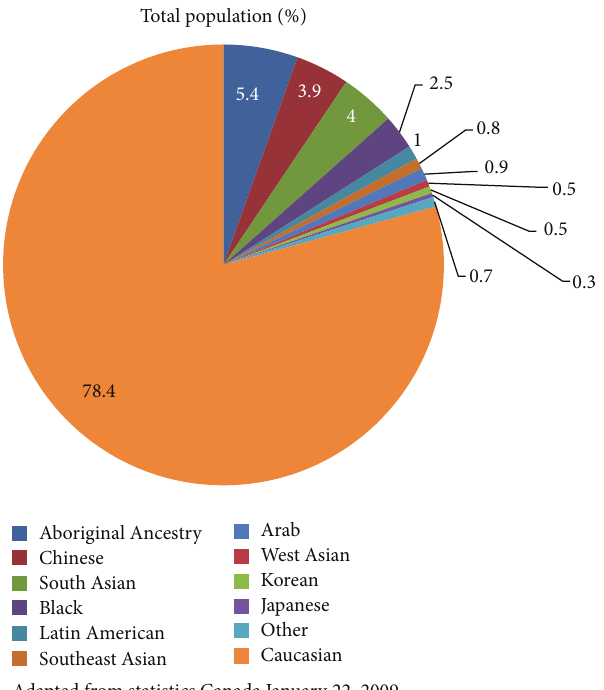
Figure 1: Canadian Population Demographics.